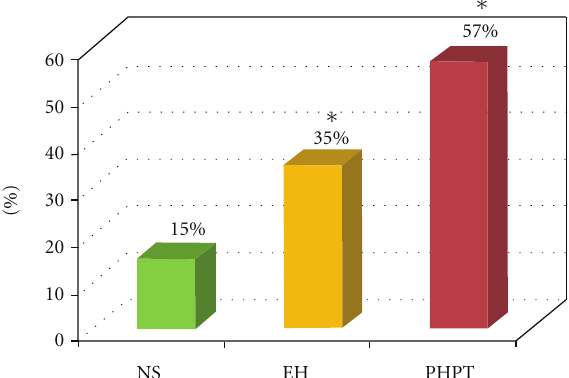
Figure 1: Prevalence of “non-dipping pattern” in all groups stud- ied. NS: normal subjects; EH: patients with essential hypertension; PHPT: patients with primary hyperparathyroidism. ∗ P = 0 . 02 versus